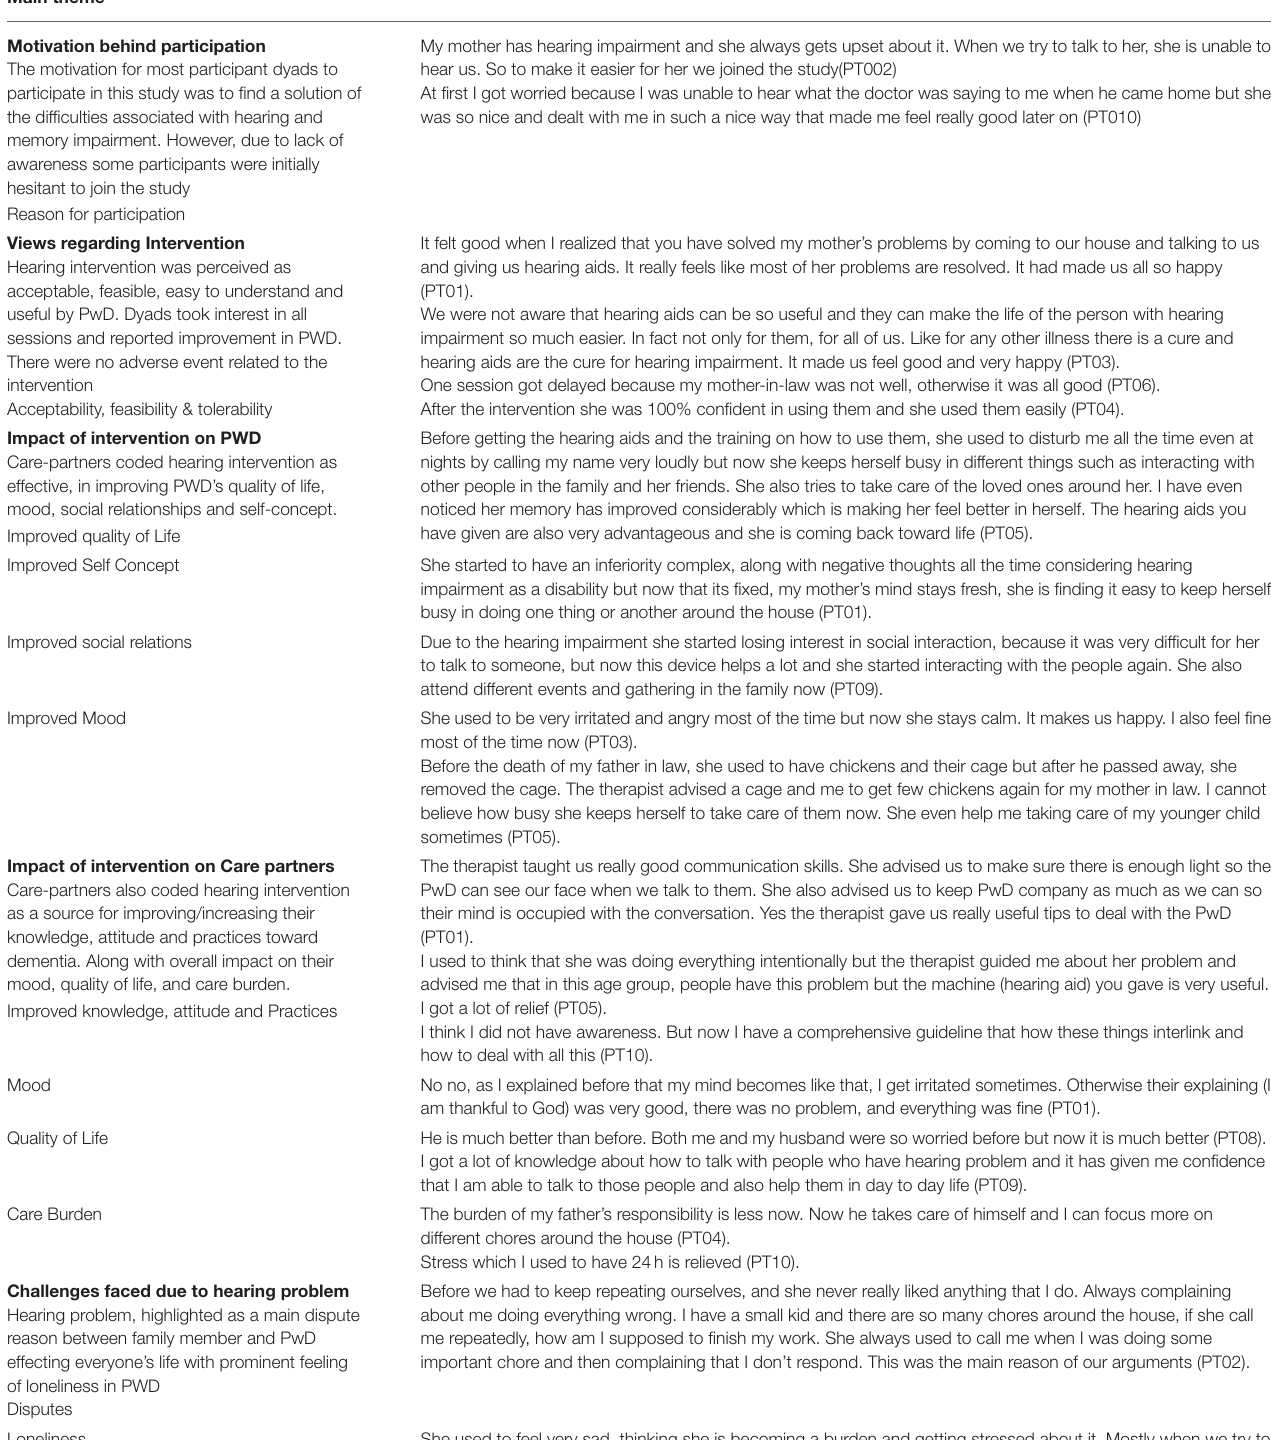
TABLE 8 | Qualitative